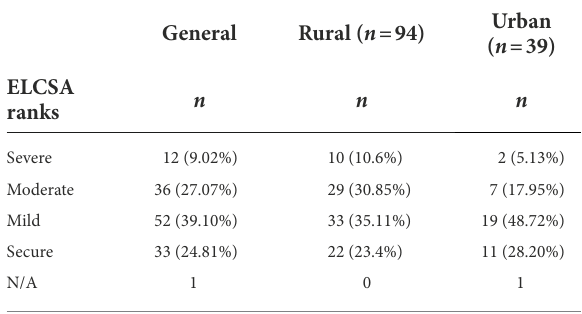
TABLE 4 Household Food Consumption Score reported in each Food Insecurity